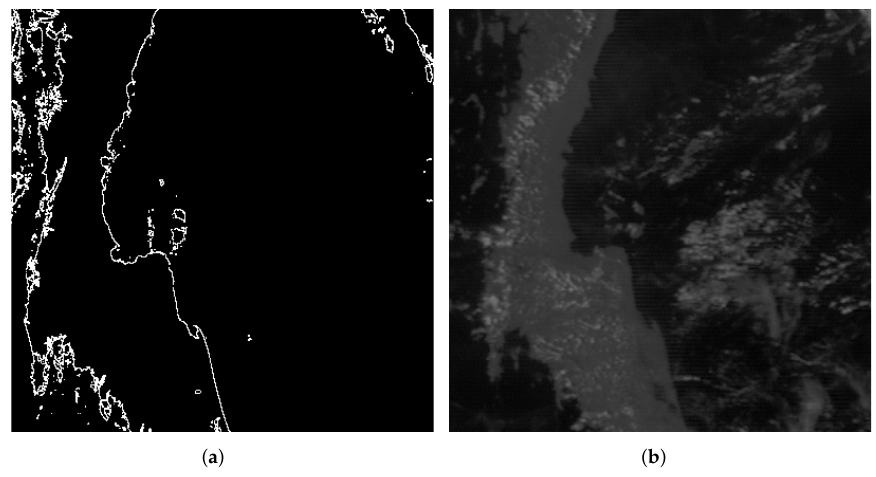
Figure 1. Some examples of landmark images and geostationary meteorological satellite (GSMS) images. ( a ) Part of the landmark image generated from the Global Self-consistent, Hierarchical, High-resolution Geography (GSHHG) database; ( b ) Part of the GSMS